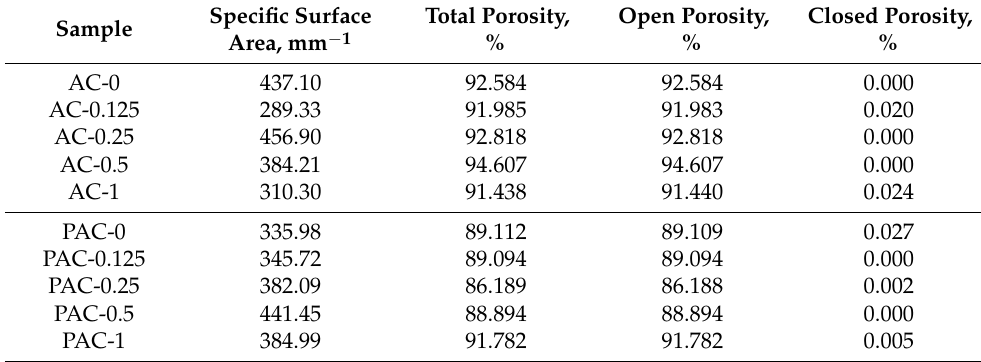
Table 2. Morphometric parameters registered through